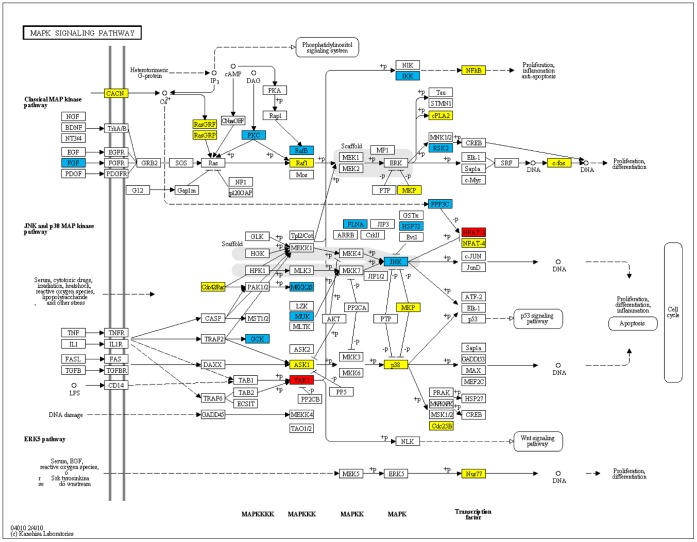
KEGG pathway for MAPK signaling.The set of genes shown in blue includes genes that are found by EU GWAS; yellow includes genes that are found by JP GWAS; red includes genes that are found both by EU and JP GWAS.